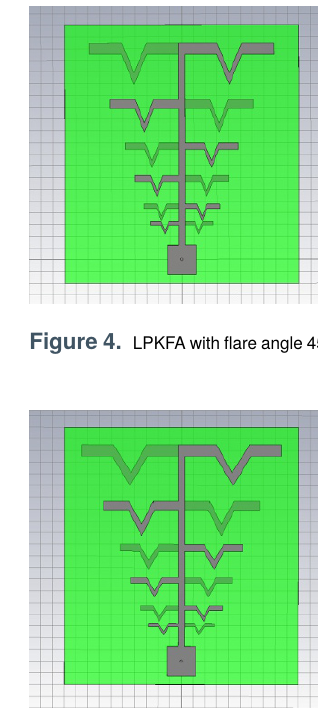
Figure 5. LPKFA with flare angle 60°.